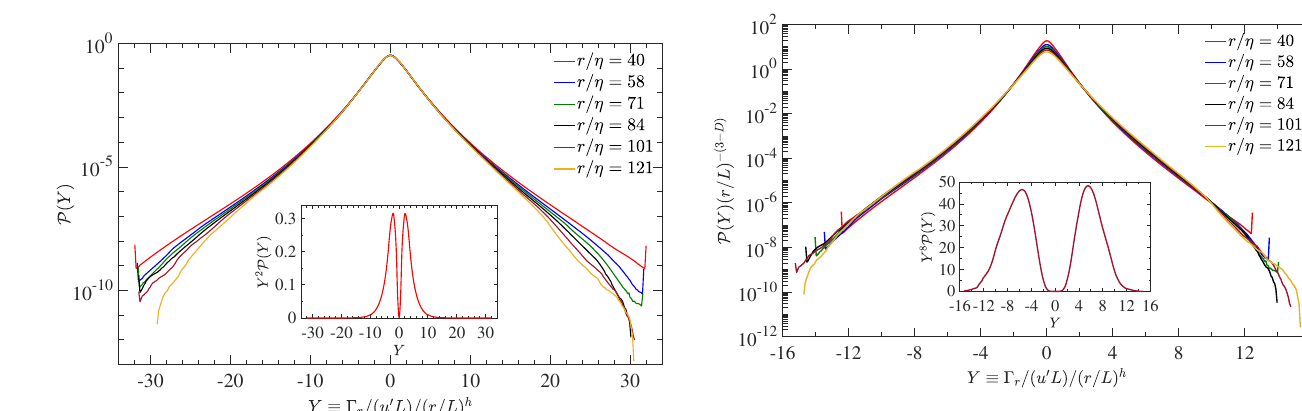
FIG. 8. Probability density function of circulation normalized by the h ≈ 1 . 4 scaling for different inertial range separations, at R ¼ 1300 . The PDF cores collapse for Y ∈ ½ − 10 ; 10 (cid:3) across the λ inertial range, while diverging for larger j Y j . Inset shows the integrand of h Y 2 i for a typical inertial separation, showing that the dominant contribution to lower-order circulation moments comes from the region where the PDFs collapse. This plot confirms that the lower-order circulation moments follow the 1.4 scaling with the space-filling dimension of three.